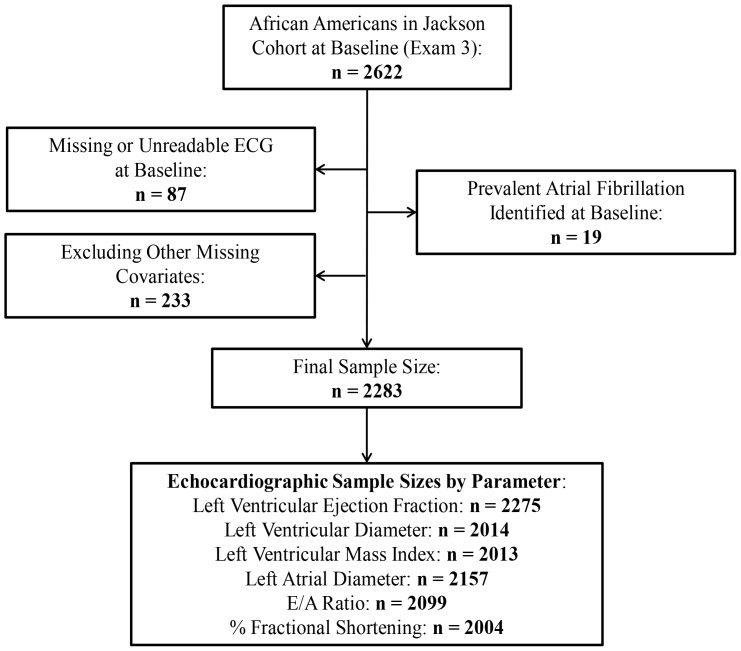
Inclusion and exclusion criteria, Atherosclerosis Risk in Communities Study Jackson Cohort, 1993–1995.